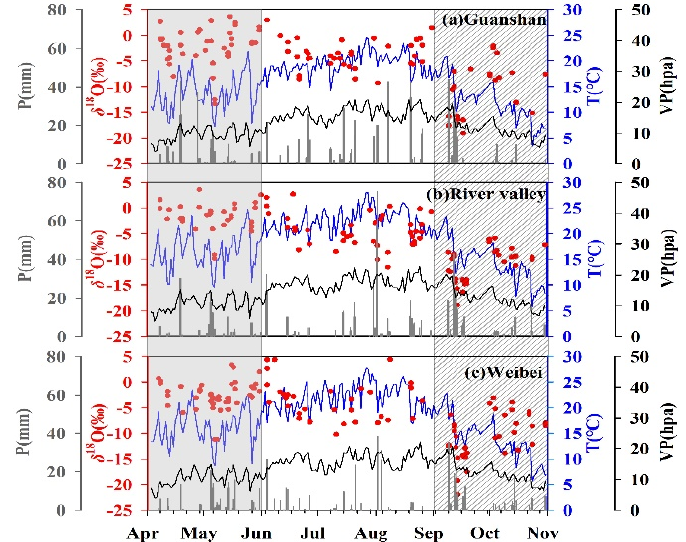
Figure 2. Temporal variation of daily precipitation δ 18 O and local precipitation amount, temperature and vapor pressure at Guanshan ( a ), River Valley ( b ) and Weibei ( c ). The grey, blank and oblique lines represent pre-monsoon, monsoon and post-monsoon seasons, respectively. Table 2. Statistical correlations between daily precipitation δ 18 O and local meteorological parameters at Guanshan, River Valley and Weibei during the different seasons.